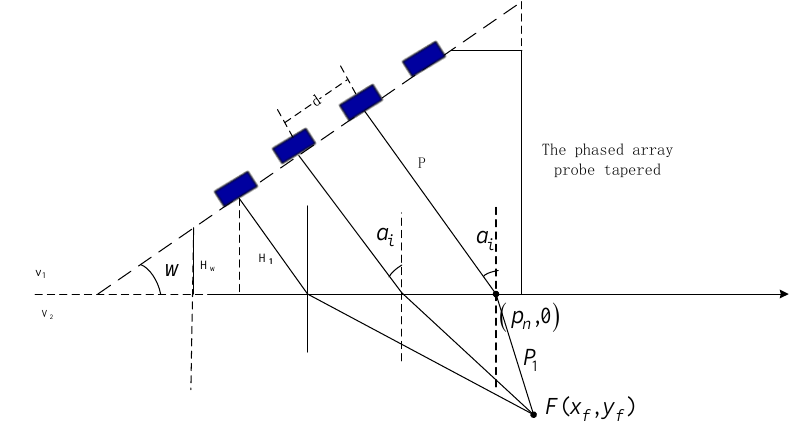
Figure 5. Focusing beam from the linear phased-array transducer in the tapered wedge.